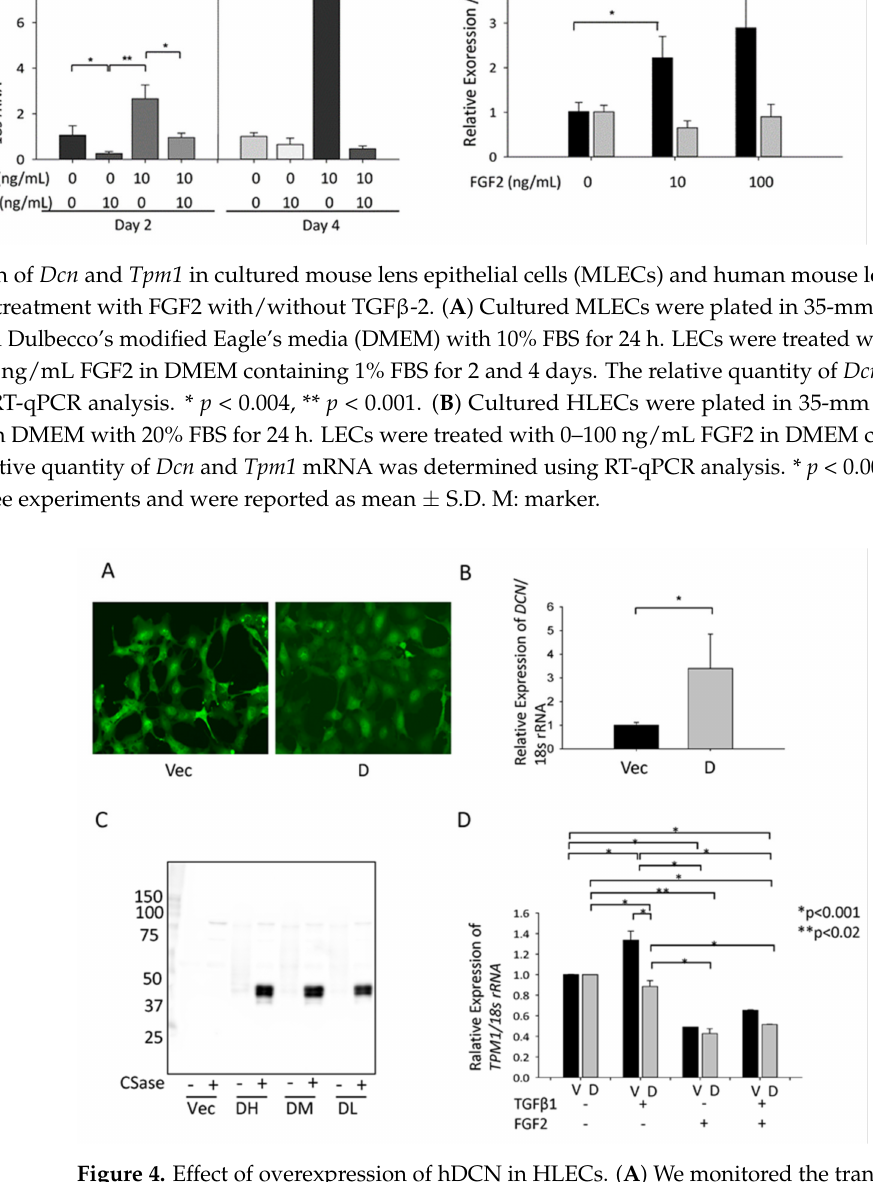
Figure 4. Effect of overexpression of hDCN in HLECs. ( A ) We monitored the transduction efficiency of GFP-vector (Vec) and GFP–hDCN (D) by observing the GFP-expressing cells within the live cell population. ( B ) RT-qPCR was performed to confirm the expression level of hDCN mRNA in GFP-vector (Vec) and GFP–hDCN (D)-overexpressing SRA-HLECs. * p < 0.05. ( C ) The collected culture supernatant was subjected to SDS-PAGE. In total, 250 ng protein was loaded per lane after concentrating the culture supernatant and digesting the GAG chain with or without protease- free chondroitinase (CSase). The secretion of DCN from SRA-HLEC overexpressing GFP–hDCN (Expression level: DH, High; DM, moderate; DL, Low) or GFP-Vec (Vec) was confirmed using western blotting. The core protein of DCN was approximately 50 kDa. ( D ) Cultured GFP-vector (V) or GFP–hDCN (D)-transfected SRA-HLECs were plated in 35-mm dishes at the density of 8 × 10 4 in DMEM with 20% FBS for 24 h. LECs were treated with 10 ng/mL TGF β -2 and/or 100 ng/mL FGF2 in DMEM containing 1% FBS and incubated for 2 days. TPM1 mRNA level was analyzed using RT-qPCR. PC; Positive control, human dermis (1 µ g/lane). * p < 0.001, ** p <